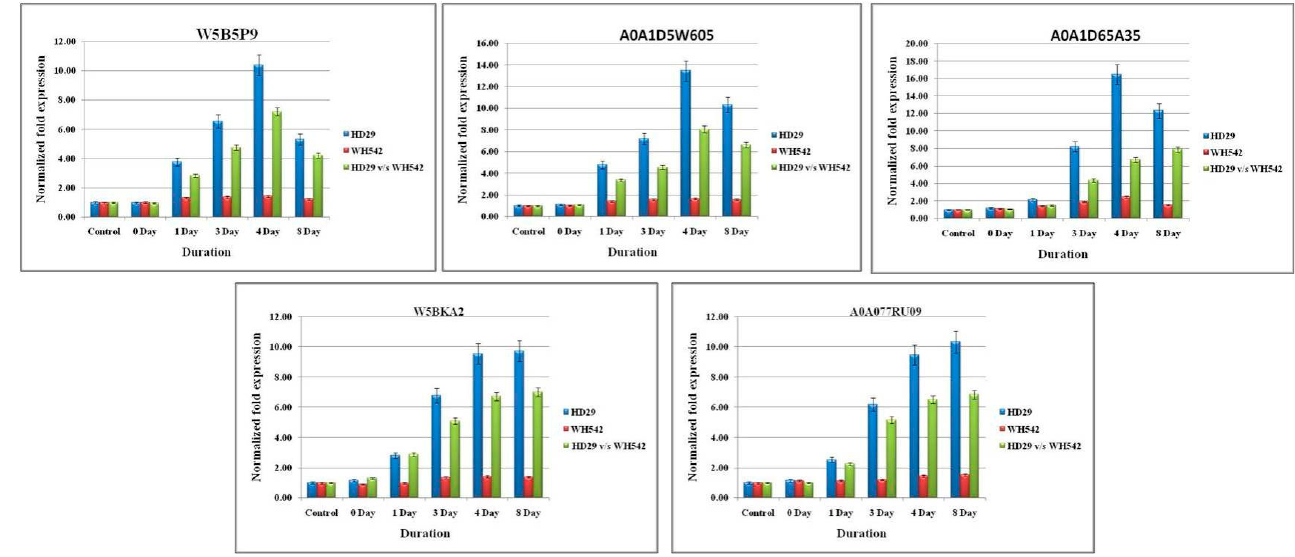
Figure 5. Real-time quantitative PCR (RT-qPCR) validation of RNA sequencing (RNA-Seq) data through randomly selected upregulated DEGs in the wheat infection. Relative fold change values were generated for RT-qPCR samples by comparing the expression of genes at each time point of infected resistant (HD29) vs. susceptible (WH542) wheat varieties. Data are presented as means ± standard error (SE) from three independent replicates.